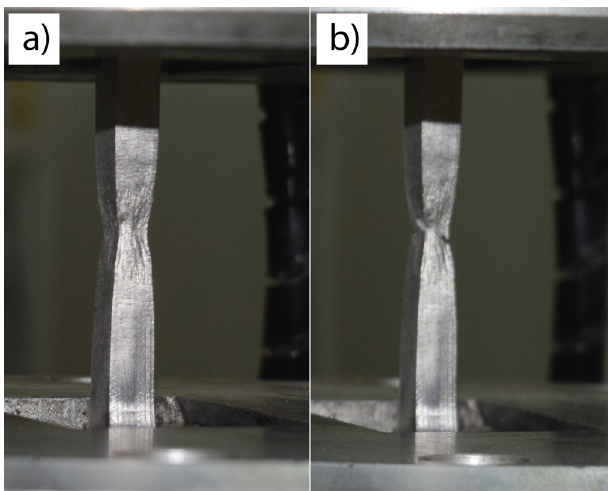
Figure 6. Tensile properties of the welds .